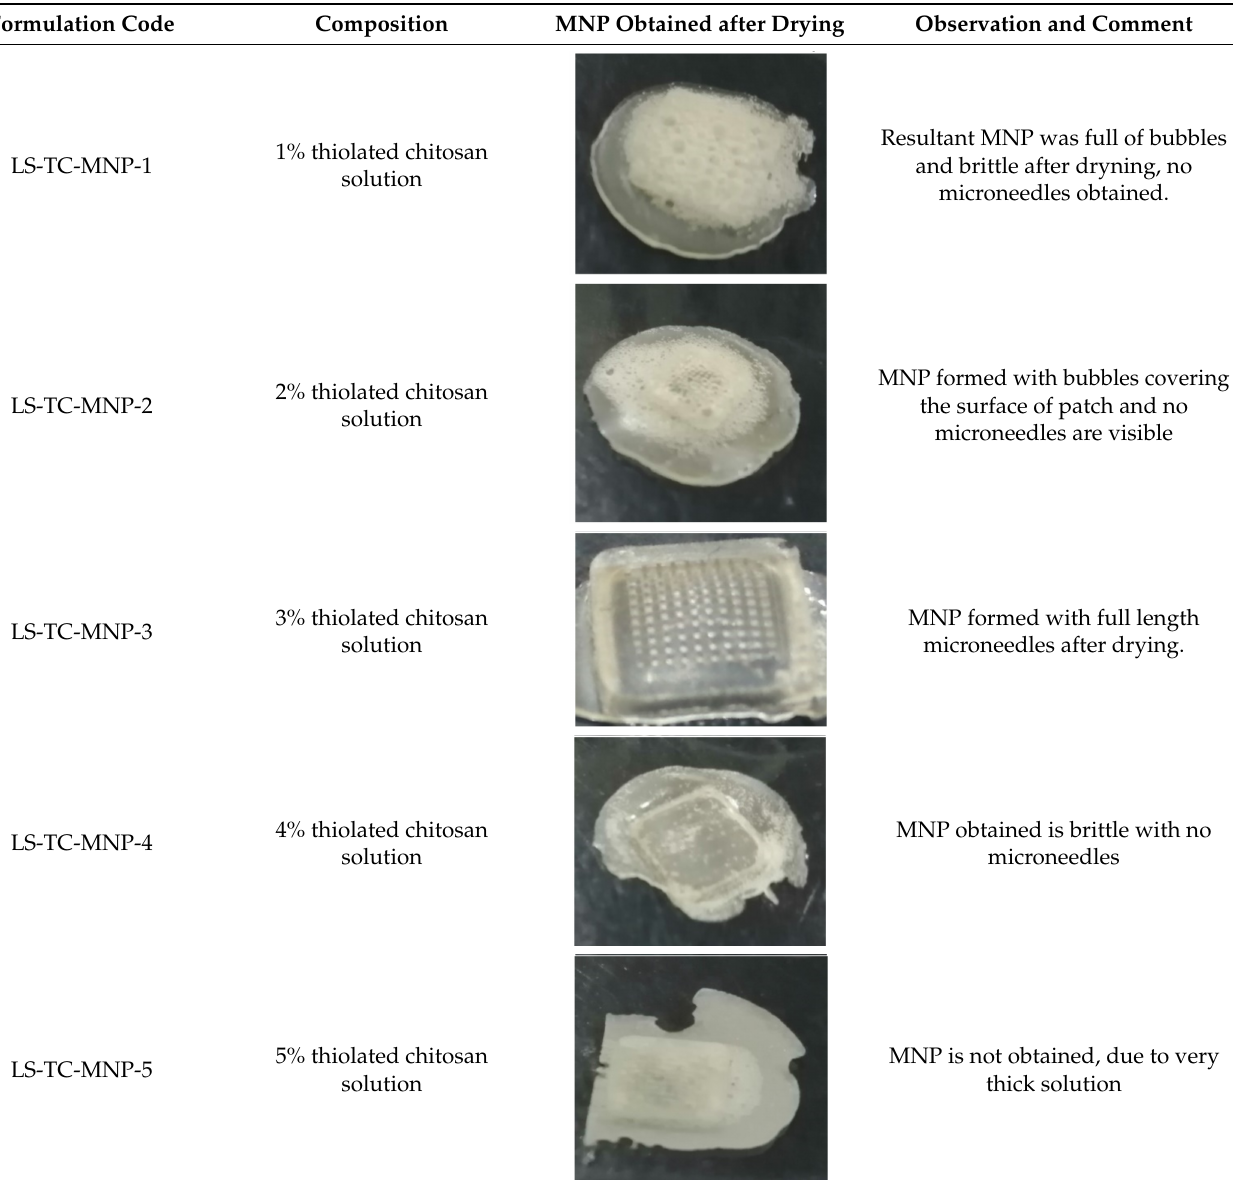
Table 1. Different formulations of microneedle patch with their respective thiolated chitosan solution concentration and resultant levosulpiride-loaded thiolated chitosan microneedle patches with images, observation, and